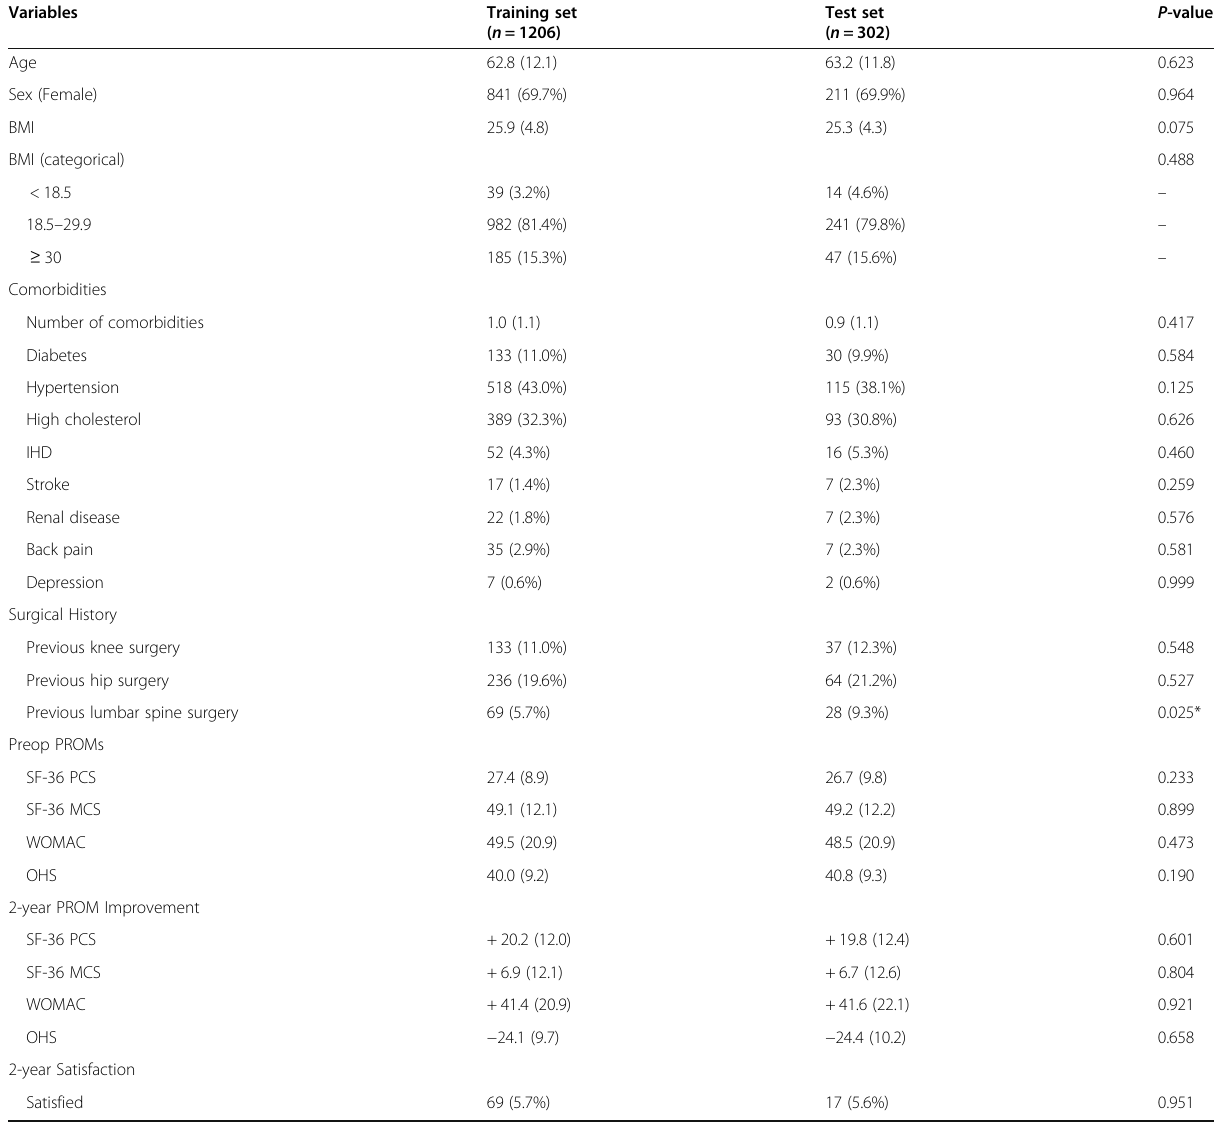
Table 2 Baseline Patient Characteristics